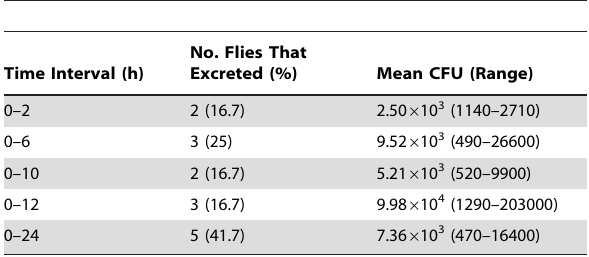
Table 1. House flies excreted viable GFP- P. aeruginosa during multiple time-intervals after